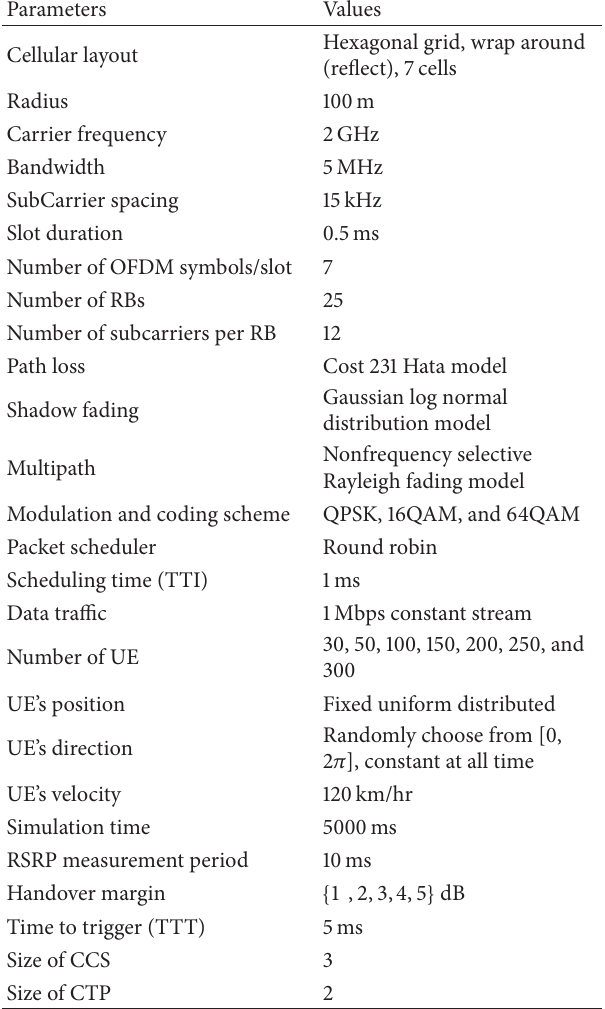
Table 1: Simulation